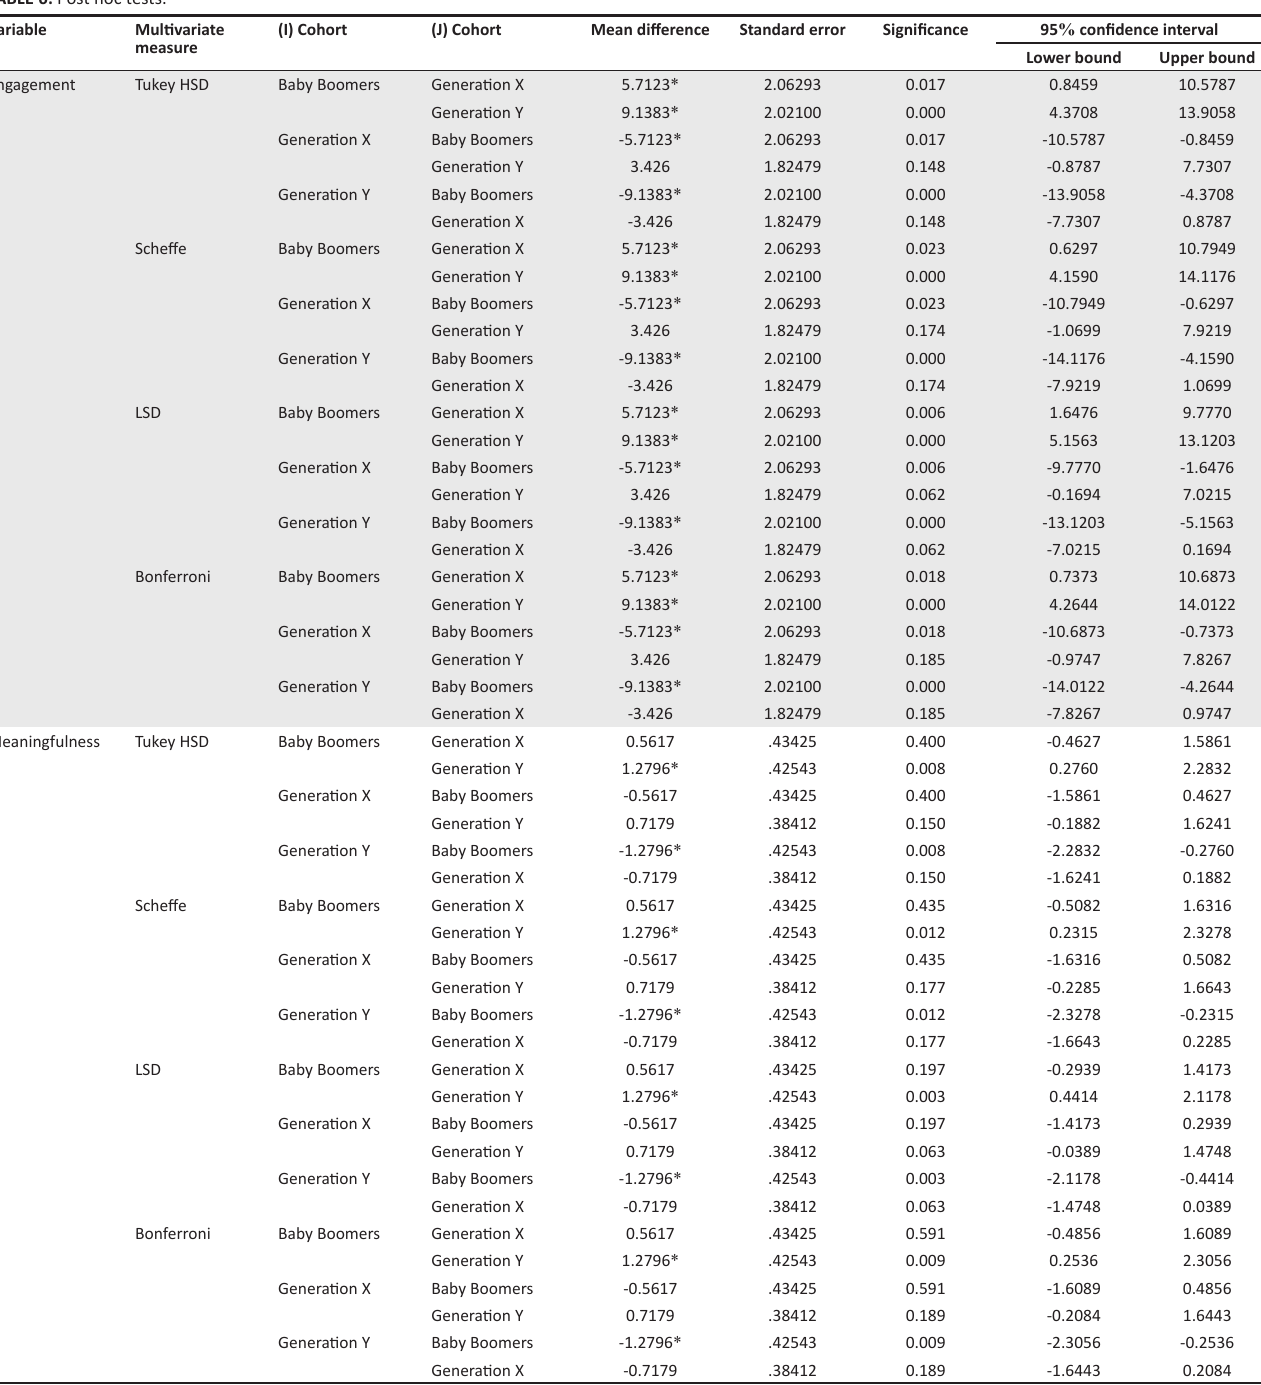
TABLE 6: Post hoc tests. Variable Multivariate